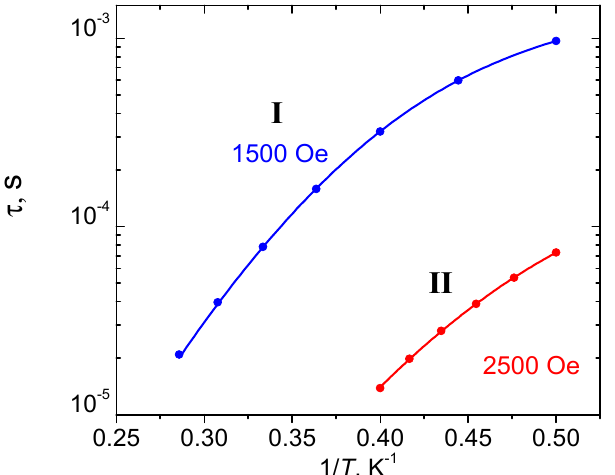
Figure 4. Dependence of the relaxation time τ on the reciprocal temperature for II ( H = 2.5 kOe, T = 2-2.5 K). Lines show approximations of the curves by the sum of the Raman and direct relaxation mechanisms (blue solid line).